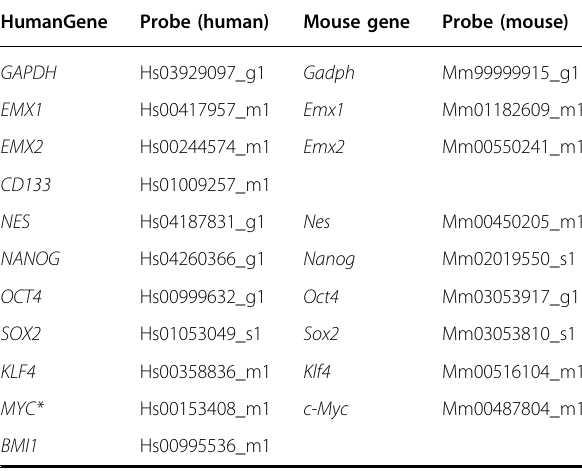
Table 3 Probes for Q-PCR used in this study.